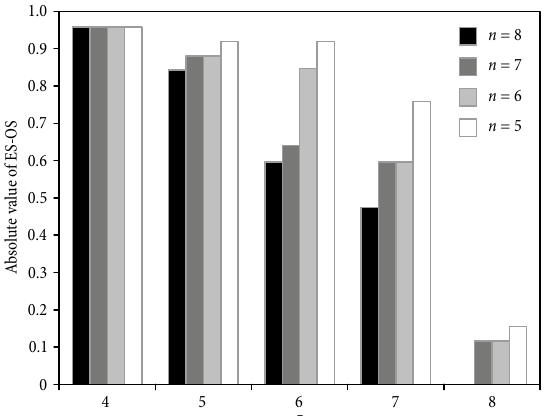
Fig. 8. Difference between ES and OS for a close to 0